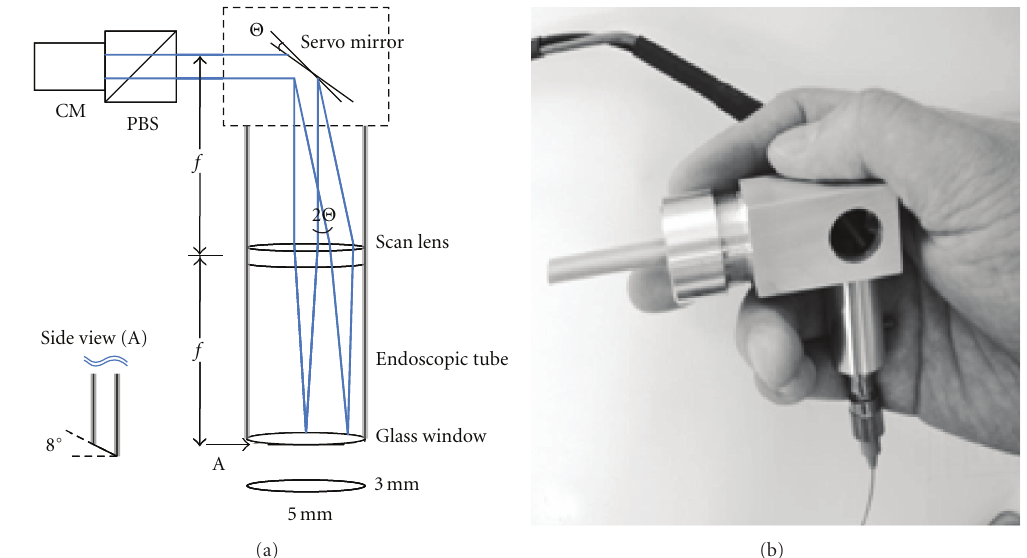
Figure 2: Arthroscopic OCT probe. (a) A schematic diagram of the OCT probe. (b) A photograph of the hand-held OCT arthroscope probe. PBS, polarization beam splitter; CM, fiber optic